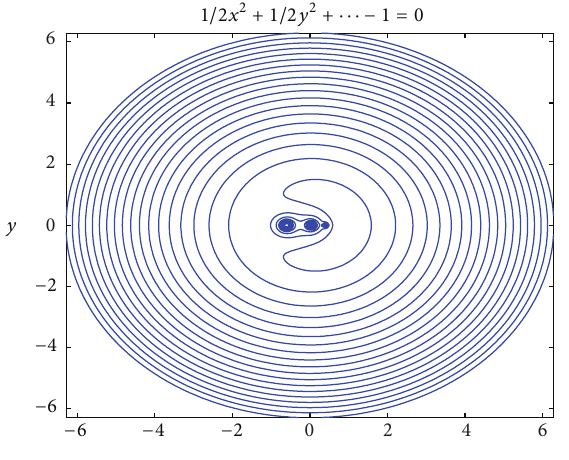
Figure 11: Curve of zero velocity (Luyten-3) 𝑞 1 = 0.999998 , 𝑞 2 = = 0.01 , 𝐴 = 0.02 . 0.99999 , and 𝐴 1 2